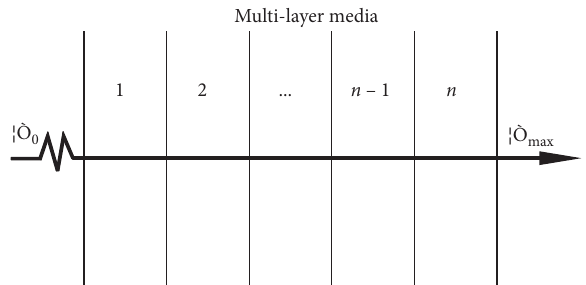
Figure 5: Normal transmission model of the stress wave in multilayer medium.